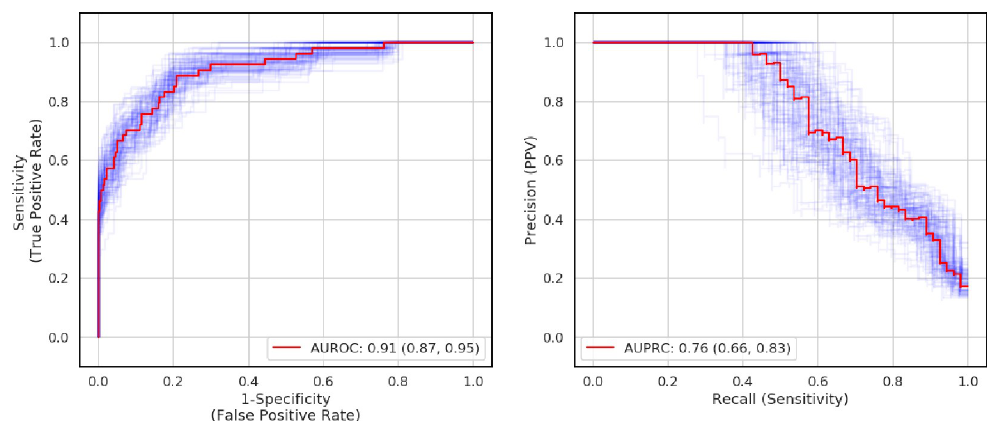
Fig 2. Performance of the model on the held-out test set (N = 392). A) Receiver operator curve. B) Precision-recall curve. At a sensitivity-optimized operating threshold, sensitivity and specificity were 0.93 (95% CI 0.85–0.98) and 0.64 (95% CI 0.59–0.69), respectively. Red solid lines were the mean receiver operator curve and mean precision-recall curve, respectively; the purple shaded lines were the curves obtained from the bootstrapping procedure to calculate the 95% confidence